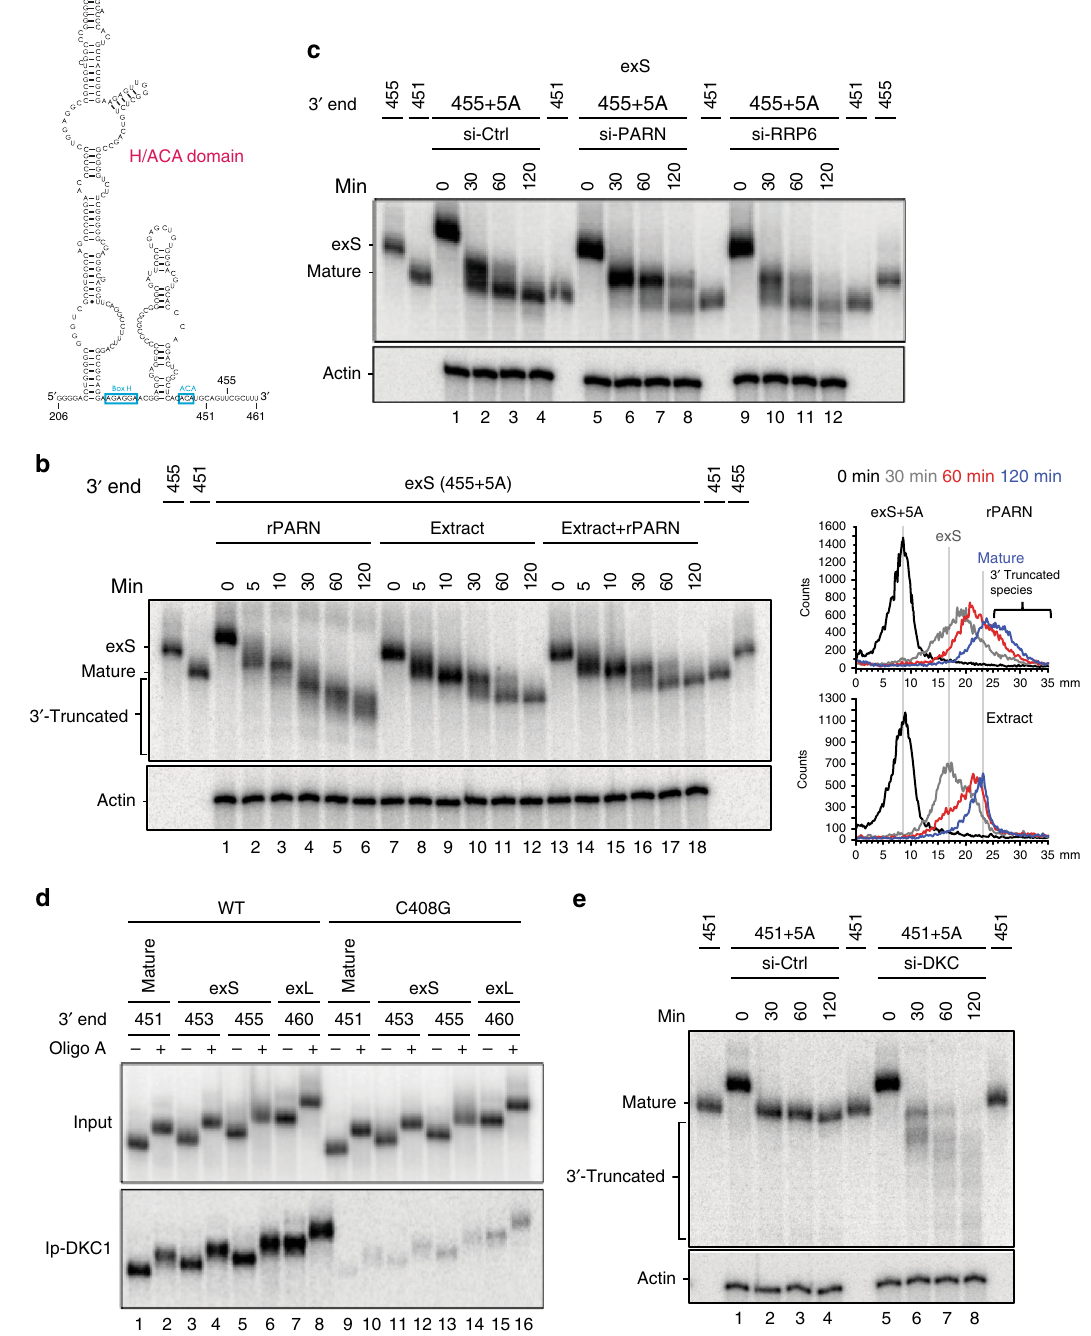
Fig. 2 PARN processing is attenuated by the H/ACA RNP. a Schematic of the hTR fragment used in the in vitro assay. b 32 P-labeled hTR fragments (nucleotides 206 to 455 with oligo A tails) were incubated with 5.0 nM of recombinant PARN alone or in HeLa cell extracts without or with 5.0 nM of recombinant PARN at 37 °C for the indicated times. RNA was puri fi ed and resolved by a 6% polyacrylamide/8 M urea gel. c The 32 P-labeled in vitro transcribed hTR fragments (nucleotides 206 to 455 with oligo A tails) was incubated in cell extracts (20 μ g) prepared from siRNA-treated cells as indicated. The reaction was performed at 37 °C for the indicated times. RNA was puri fi ed and resolved by a 6% polyacrylamide/8 M urea gel. d Wild type or C408G mutant hTR fragments (nucleotides 206 to 451, 453, 455, and 460 with or without oligo A tails) were in vitro transcribed in the presence of α - 32 P-UTP and incubated in HeLa cell extracts on ice for 10 min. The reaction mixture was immunoprecipitated with antibodies against dyskerin. RNA was puri fi ed and resolved by a 6% polyacrylamide/8 M urea gel. e The 32 P-labeled in vitro transcribed hTR fragments (nucleotides 206 to 451 with oligo A tails) were incubated in cell extracts (20 μ g) prepared from siRNA-treated cells as indicated. The reaction was performed at 37 °C for the indicated times. RNA was puri fi ed and resolved by a 6% polyacrylamide/8 M urea